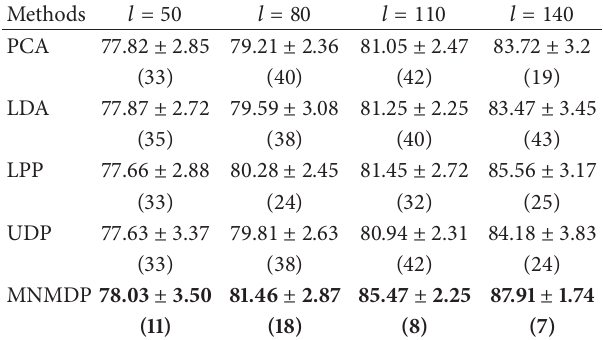
Table 4: The maximal average recognition rates (%) of each method on Musk with the corresponding standard deviations (stds) and values of dimension in the